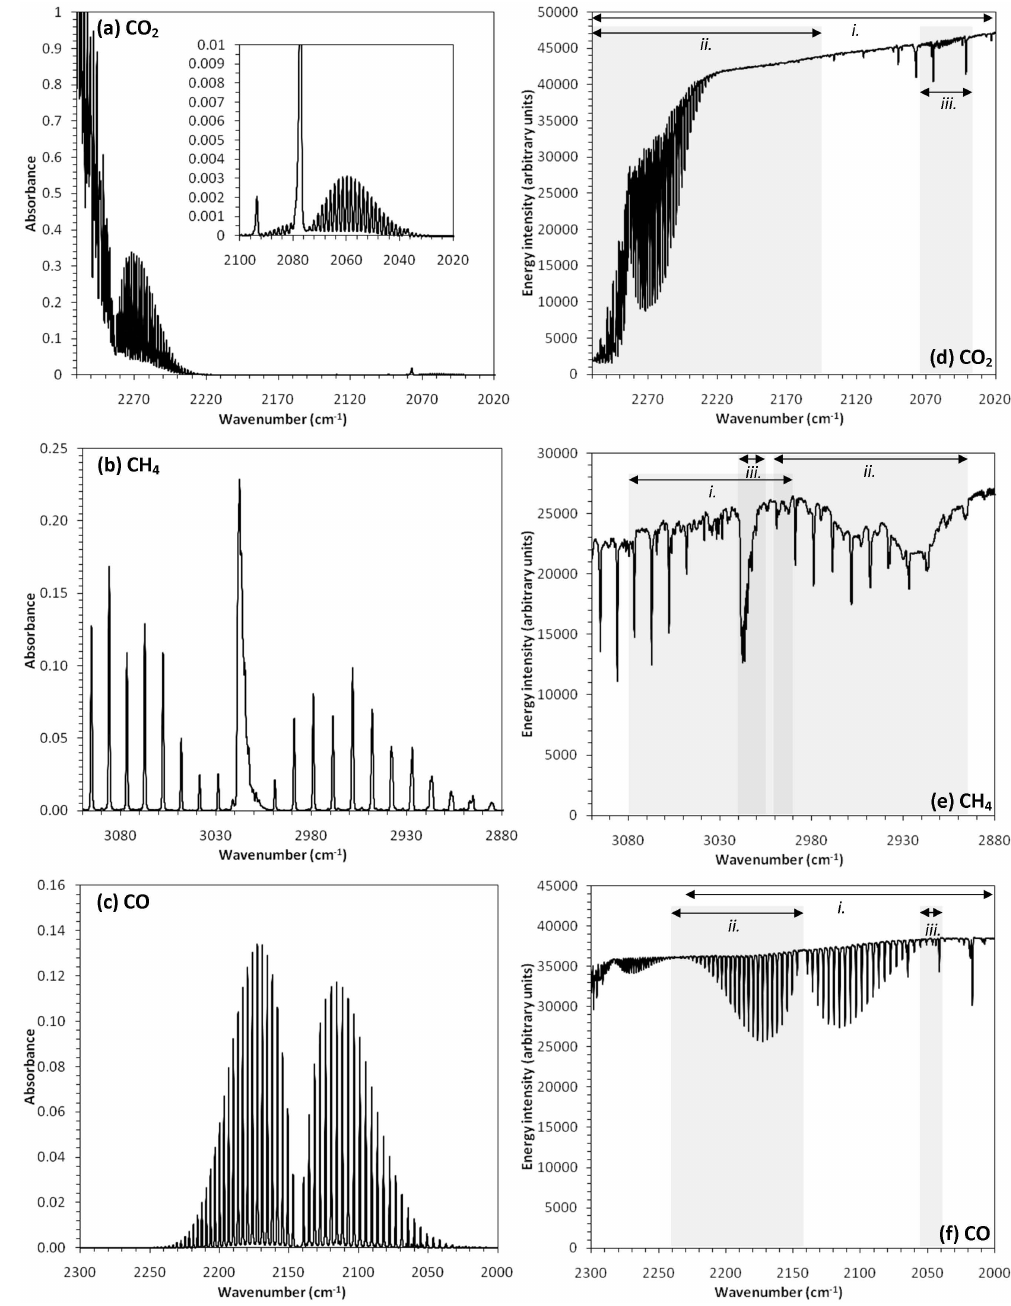
Fig. 4. Modelled and measured spectra at 0.5cm − 1 wavenumber resolution for the CO 2 , CH 4 , and CO trace gases considered here. (left) Absorbance spectra modelled using the MALT forward model; (right) Measured FTIR single-beam spectra. The various spectral windows used to retrieve the trace gas concentrations from the measured spectra are indicated by the numbered horizontal arrows in (d) , (e) , (f) and are detailed in Table